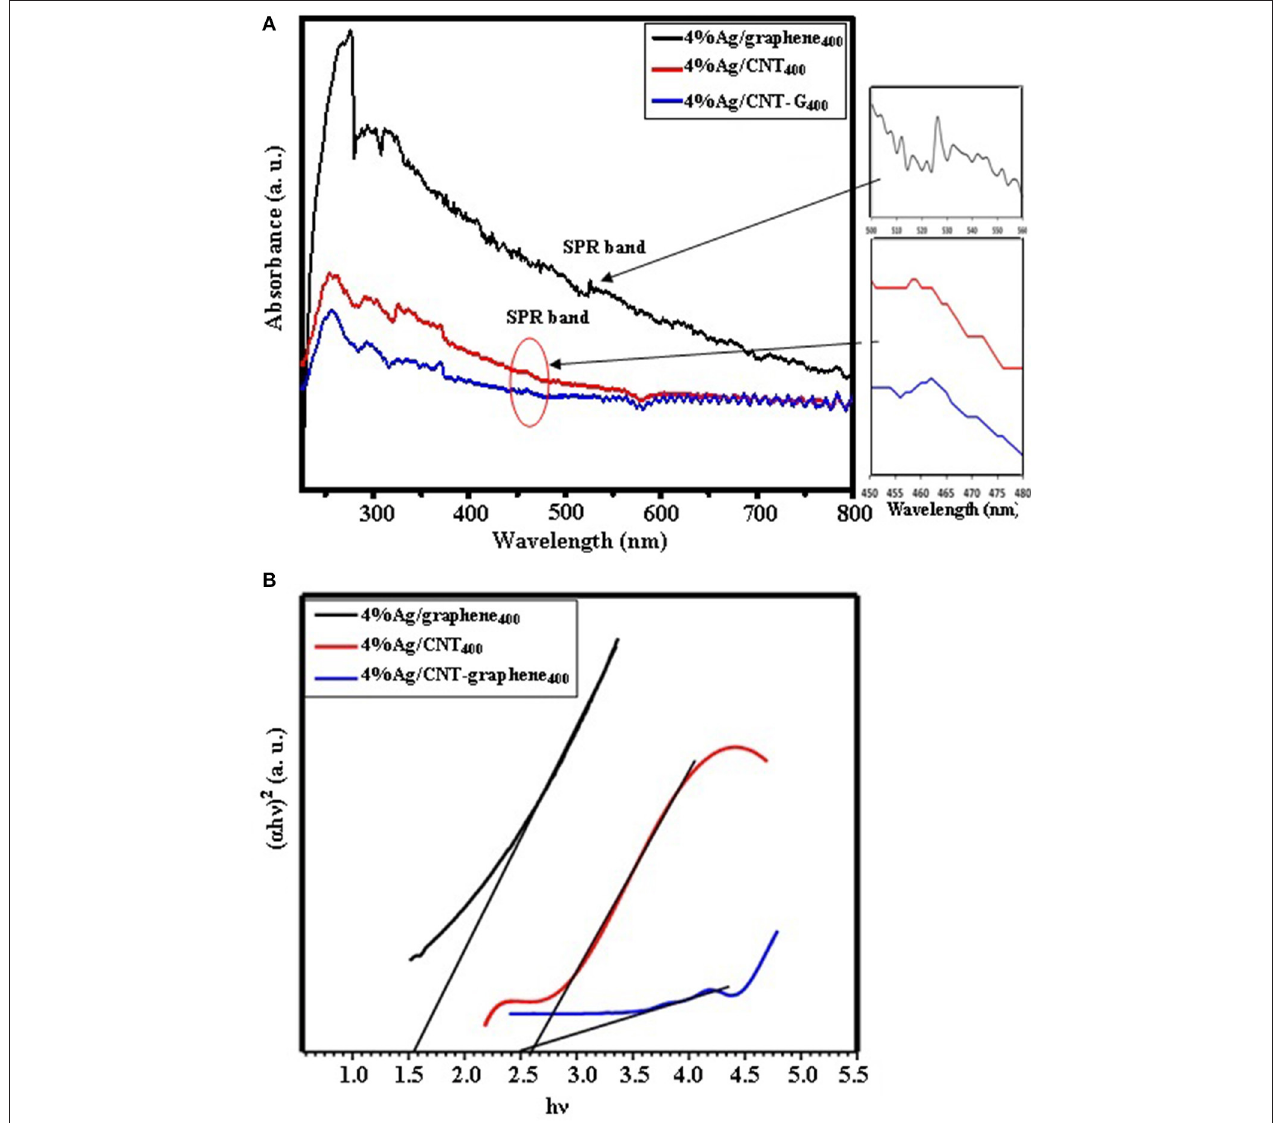
FIGURE 6 | (A) UV-visible spectra of 4%Ag/graphene 400 , 4%Ag/CNT 400 , and 4%Ag/CNT-graphene 400 . (B) Band gap energy plots of 4%Ag/graphene 400 , 4%Ag/CNT 400 , and 4%Ag/CNT-graphene 400